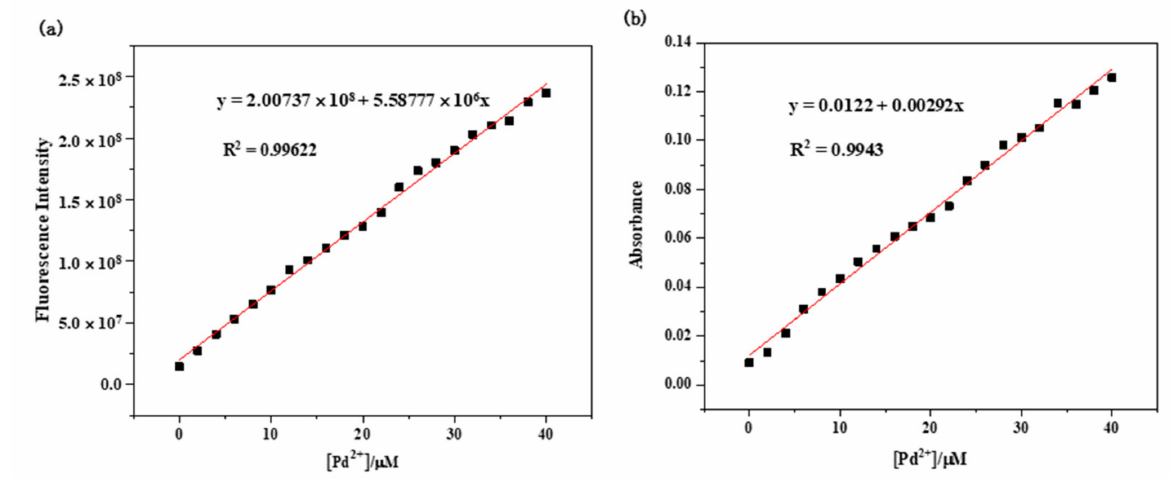
Figure 3. Linear relationships at the excitation wavelength of 635 nm: ( a ) fluorescence intensity at 735 nm of the RCya + Pd 2+ system; ( b ) absorbance at 713 nm of the RCya + Pd 2+ system.